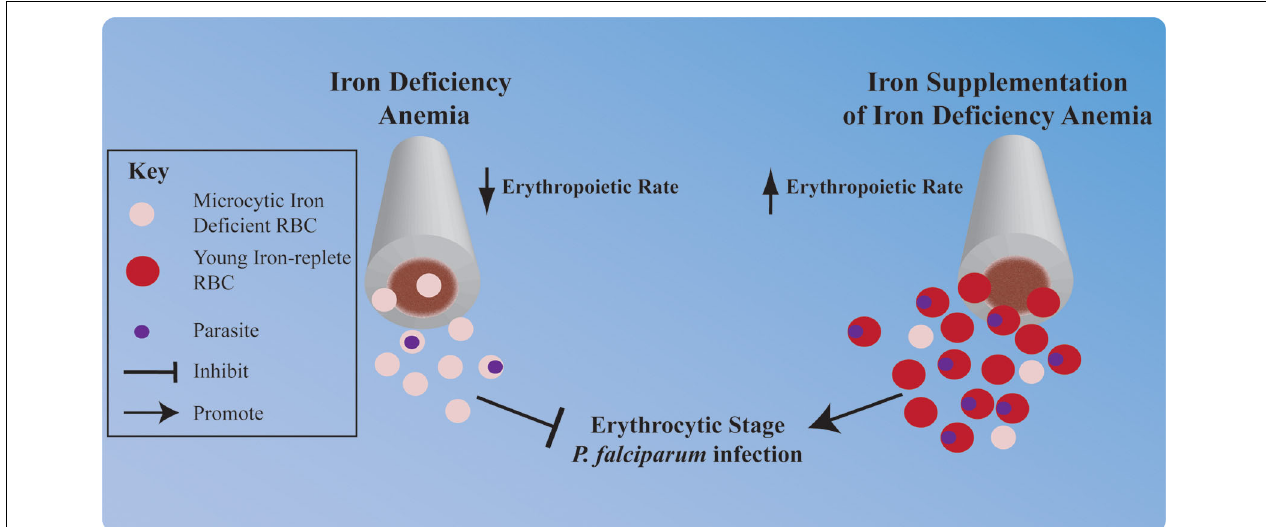
FIGURE 2 | Hypothesized impact of iron deficiency anemia and iron supplementation on P. falciparum erythrocytic infection. Iron deficiency anemia and iron supplementation each profoundly influence human erythropoiesis, and this may influence erythrocytic stage malaria infection. Iron deficiency induced reduction in the erythropoietic rate and synthesis of